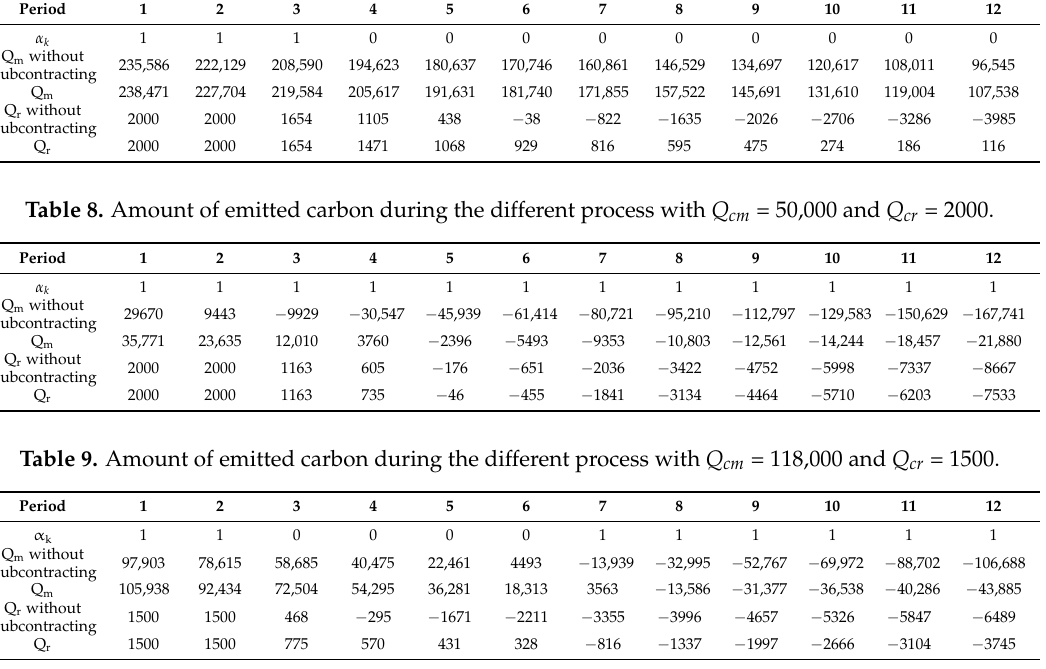
Table 7. Amount of emitted carbon during the different process with Q cm = 200,000 and Q cr = 2000. Period